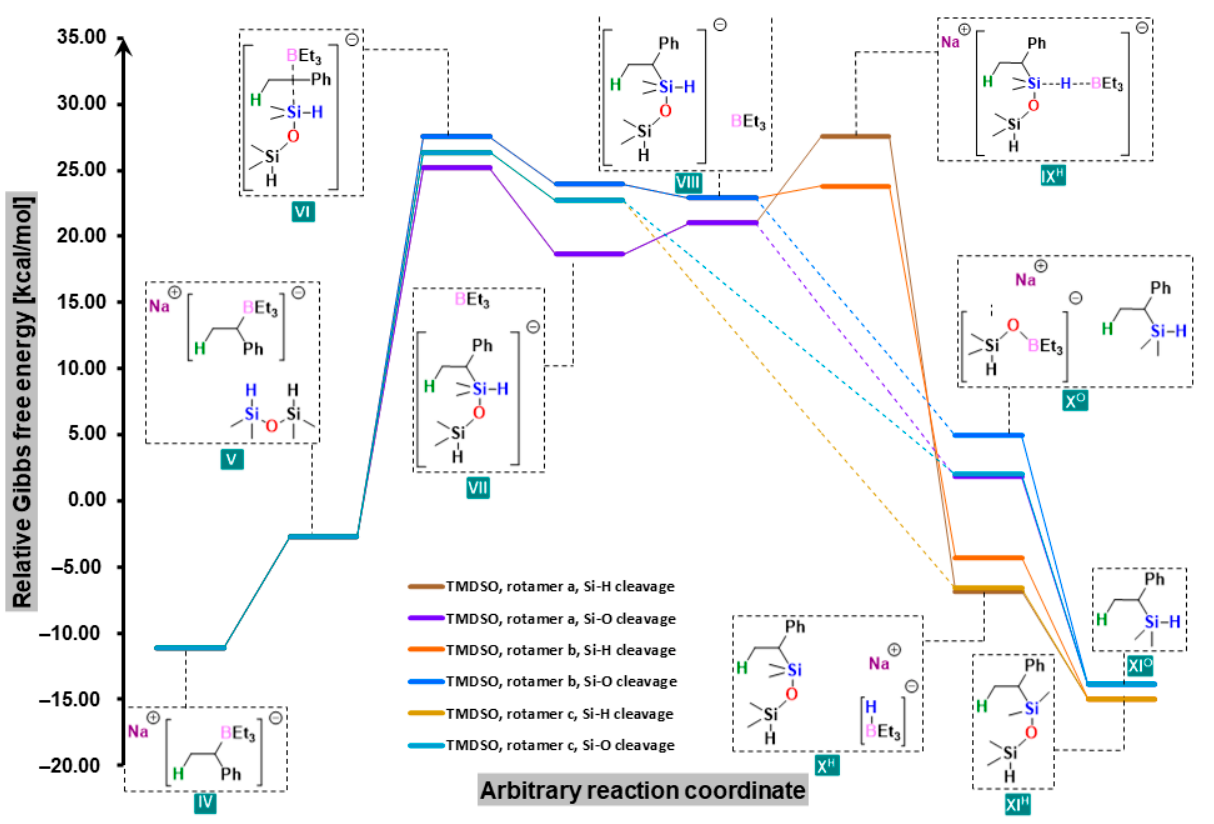
Figure 1. Free-energy profiles for two possible pathways of the reaction of styrene with TMDSO in the presence of sodium trialkylborohydride.